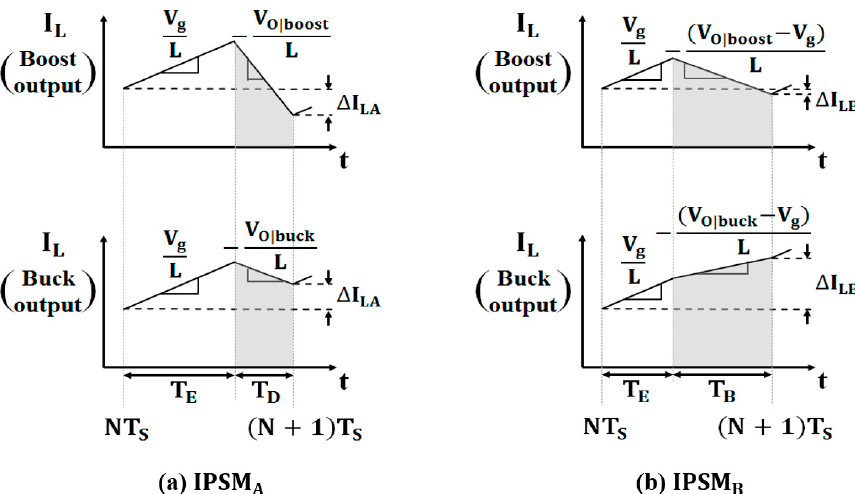
Figure 3. Illustrating inductor current waveforms of two inductor power switching mode modes ( a ) energizing and then de-energizing phases (we named the inductor power switching mode A (IPSM A )) and ( b ) energizing and then bypassing phases (named IPSM B ). The proposed error-driven randomized control (EDRC) employs both inductor power switching